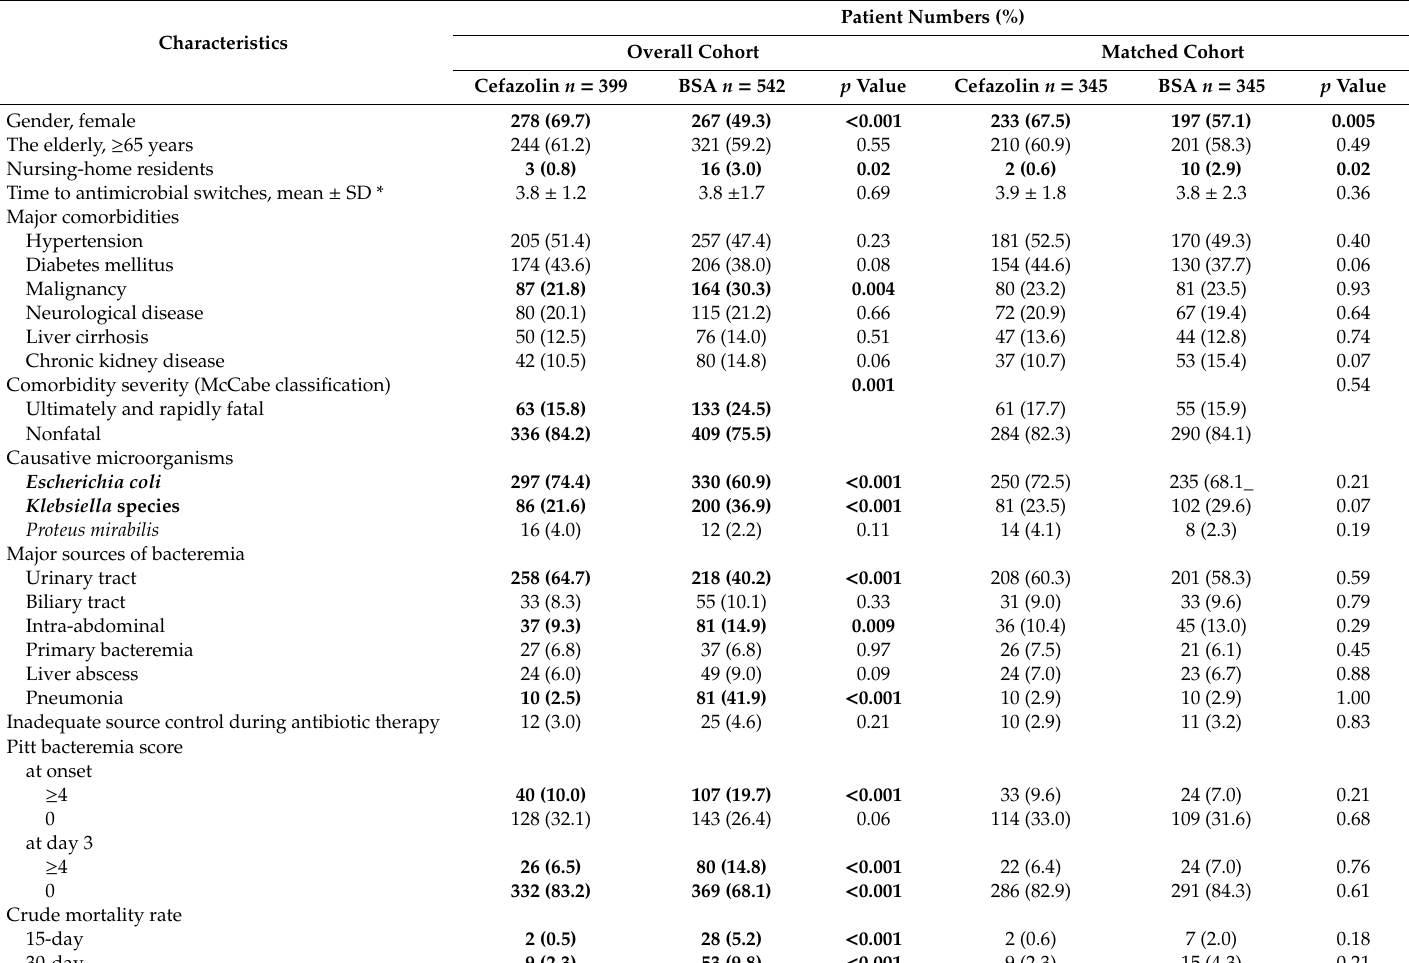
Table 1. Clinical characteristics and patient outcomes in the cefazolin and broader-spectrum antibiotic (BSA)